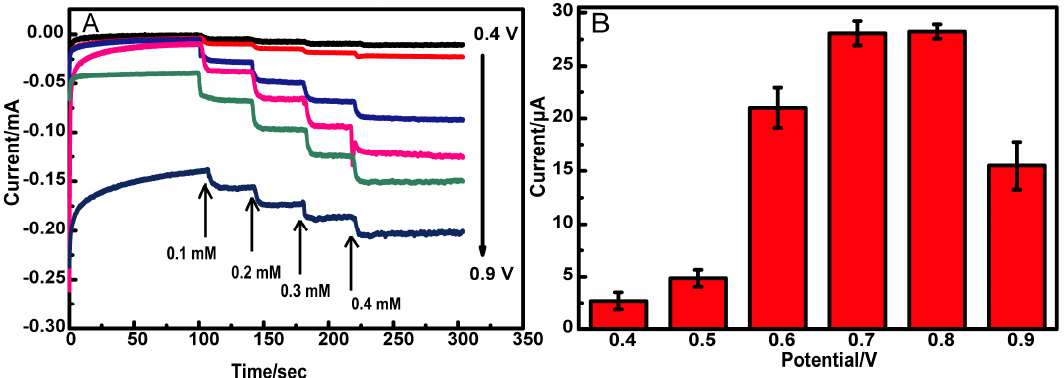
Figure 6. ( A ) i-t curve of the CuO/PCL@PPy/ITO electrode by successively for four times, adding 0.1 mM glucose into 10 mL 0.01 M NaOH solution recorded at different detection potentials: 0.4 V, 0.5 V, 0.6 V, 0.7 V, 0.8 V and 0.9 V; ( B ) Comparable graph for current changes by adding 0.1 mM glucose into 10 mL 0.01 M NaOH solution, recorded at different detection potentials.